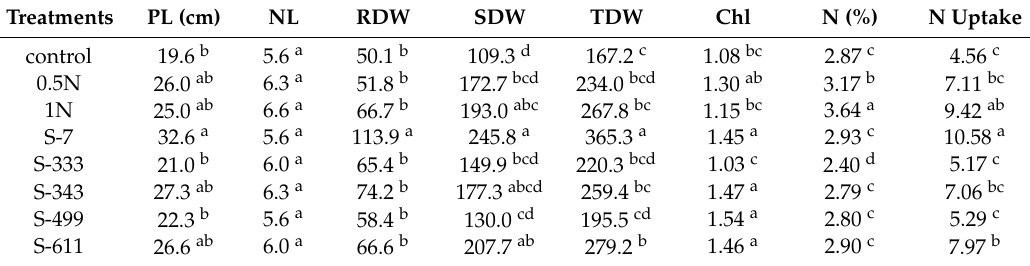
Table 5. Growth response of upland rice to bacterial inoculation 60 DAI under greenhouse conditions. Plant length (PL), number of leaves (NL), root dry weight (RDW, mg), shoot dry weight (SDW, mg), total plant dry weight (TDW, mg plant − 1 ), and total chlorophyll content (Chl, mg g − 1 fresh weight). Nitrogen (N) uptake was expressed in mg pot − 1 .